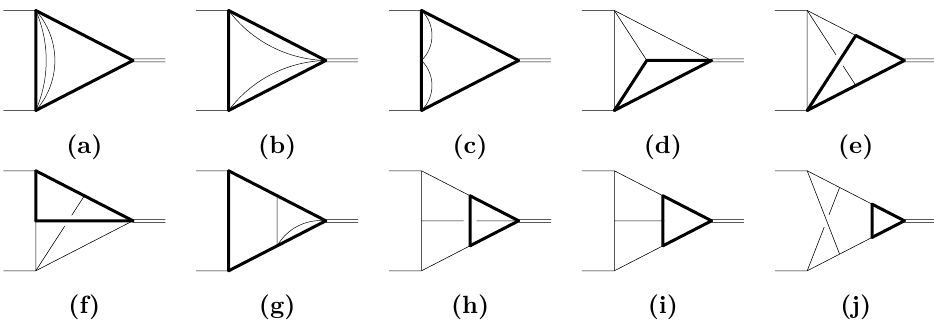
and the outgoing double line carries the Higgs q